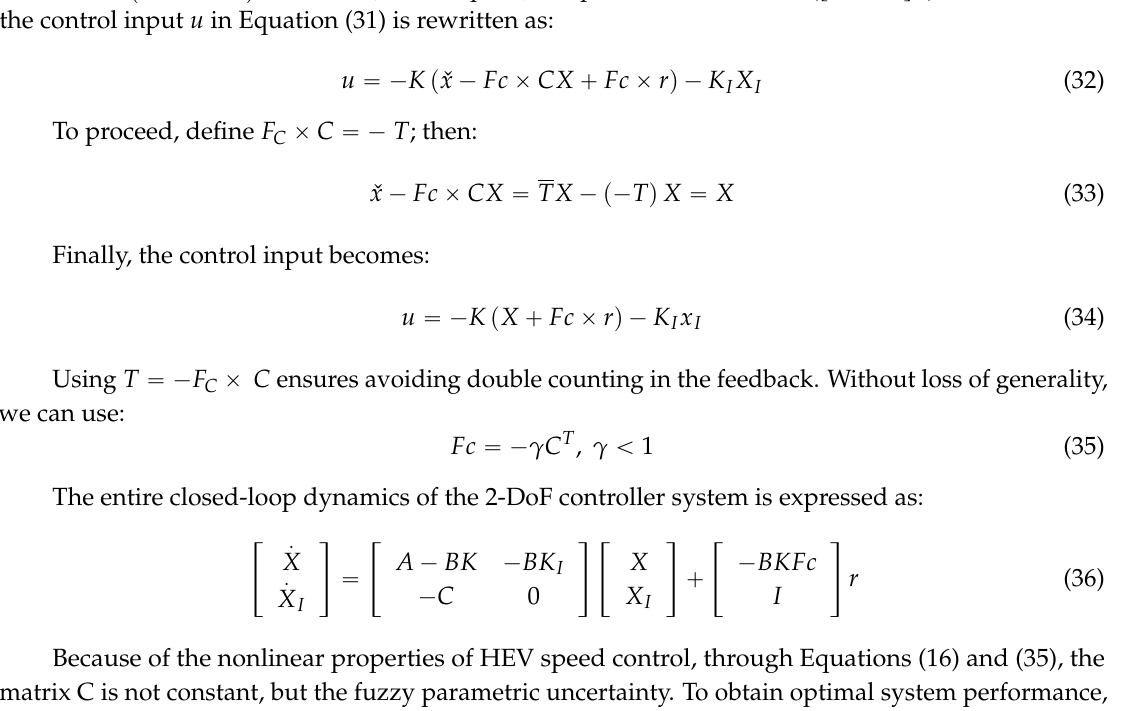
Figure 5. Block diagram for the HEV longitudinal speed control with forward compensator.